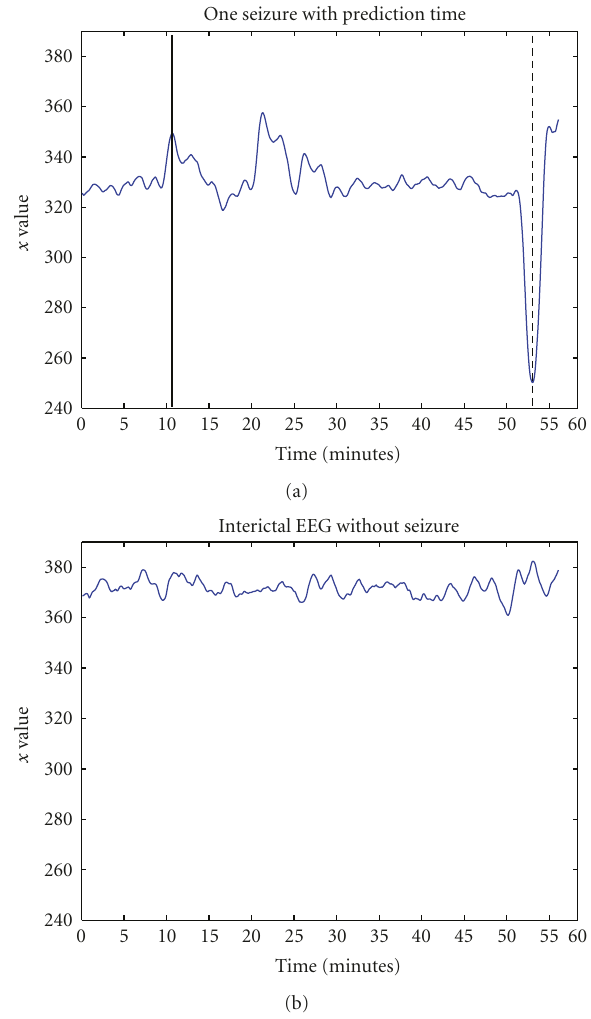
Figure 2: Ictal and interictal hidden variable x from one patient with epilepsy. The vertical solid line marks prediction time point and the vertical dashed line indicates seizure